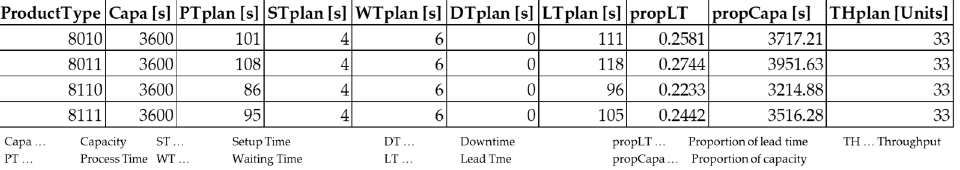
Figure 12. Data to create the initial production schedule for test series one.